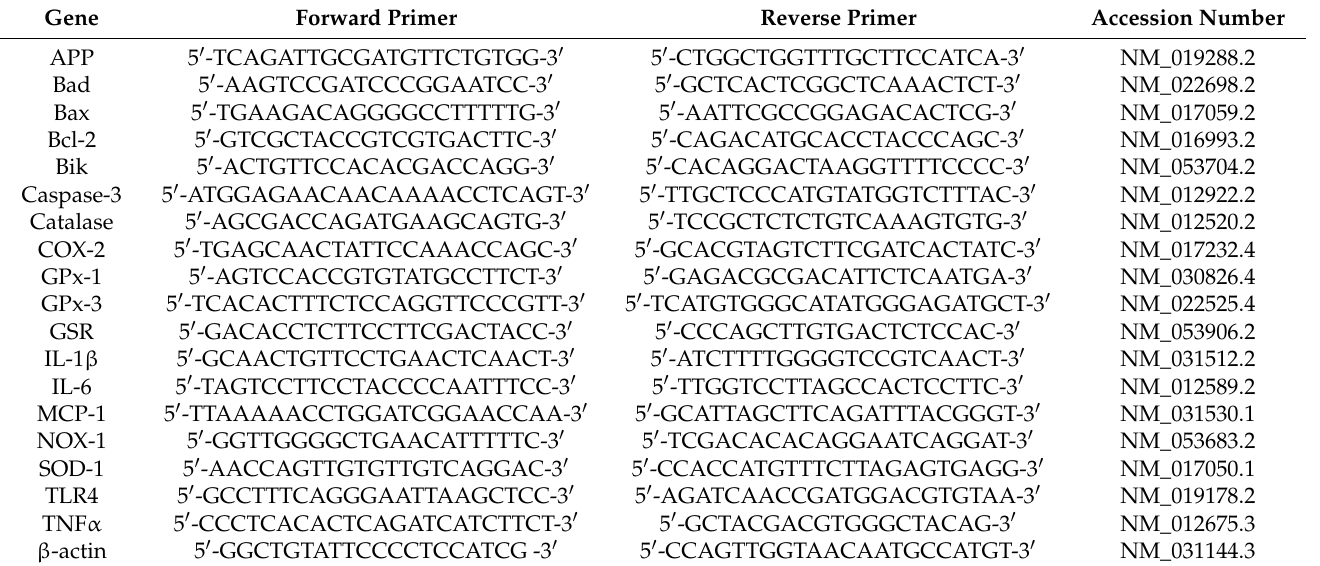
Table 1. Oligonucleotide primer sequences used in real-time